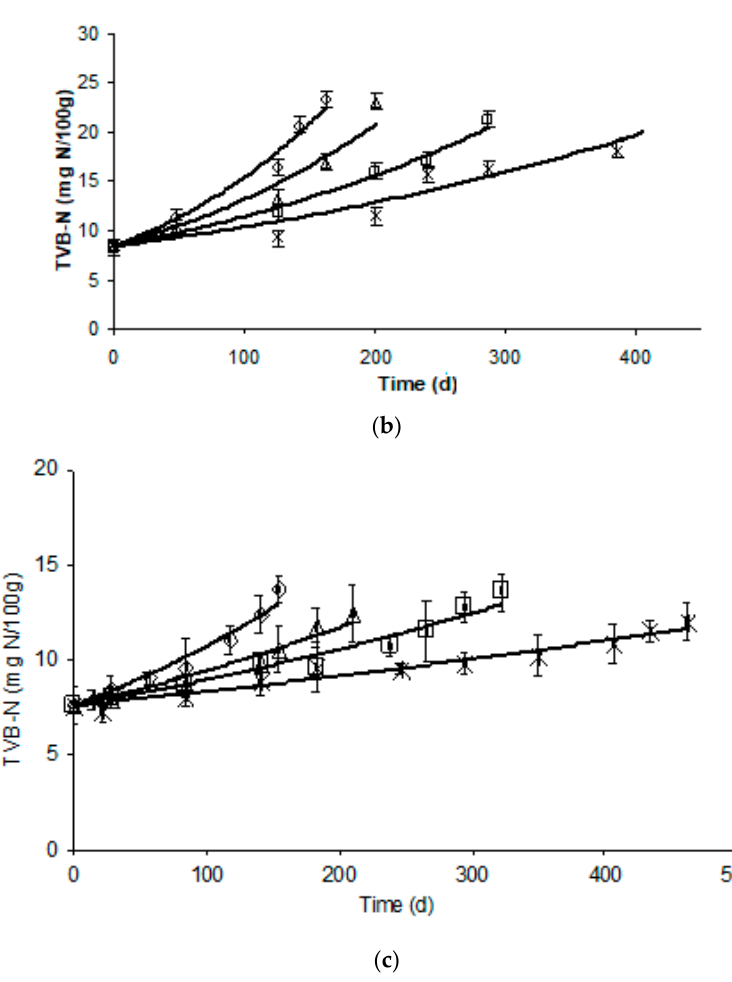
Figure 4. Changes in the total volatile basic nitrogen (TVBN) of thawed ( a ) gilthead sea bream fillets, ( b ) sea bass fillets and ( c ) yellowfin tuna slices during storage at − 5, ∆ − 8, − 12 and ∗ − 15 °C. (Error bars indicate standard error of measurements of two different samples.) (1 a : R 2 − 5°C = 0.963, R 2 − 8°C = 0.924, R 2 − 12°C = 0.885, R 2 − 15°C = 0.931; 1 b : R 2 − 5°C = 0.983, R 2 − 8°C = 0.963, R 2 − 12°C = 0.990, R 2 − 15°C = 0.930; 1 c : R 2 − 5°C = 0.964, R 2 − 8°C = 0.923, R 2 − 12°C = 0.885, R 2 − 15°C = 0.931.)